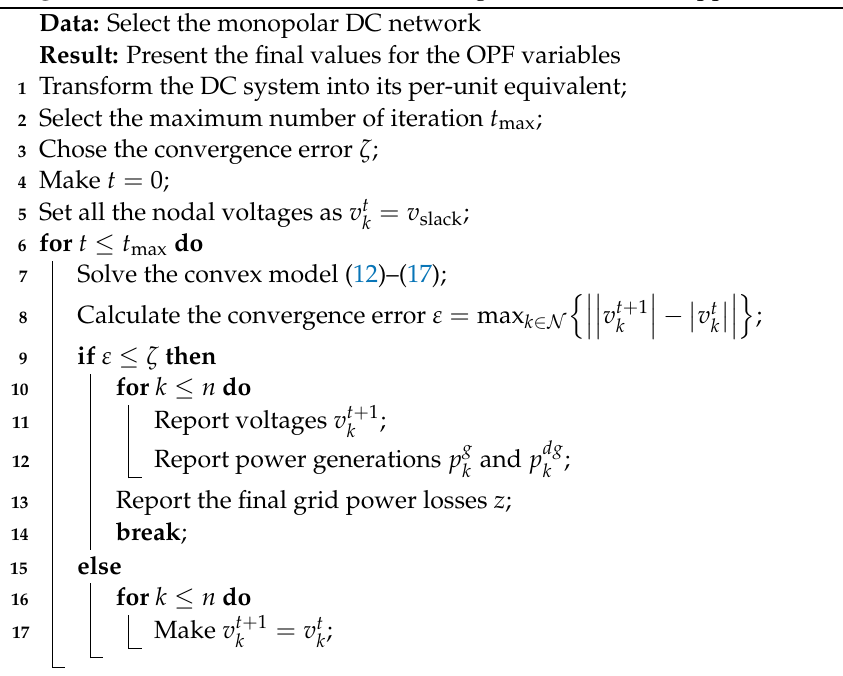
Algorithm 1: Recursive OPF solution using a relaxed convex